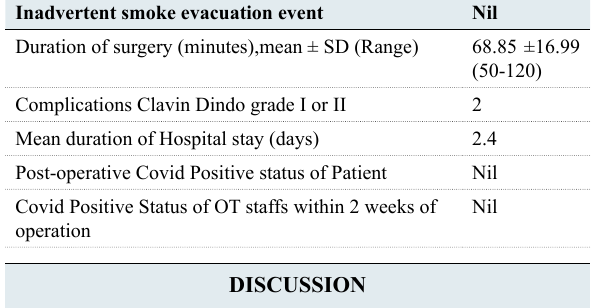
Table 3: Intraoperative and post-operative Parameters Inadvertent smoke evacuation